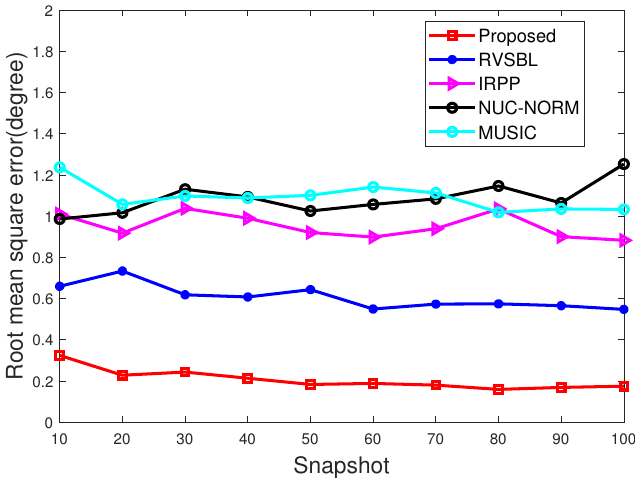
Figure 6. RMSE with different snapshots.